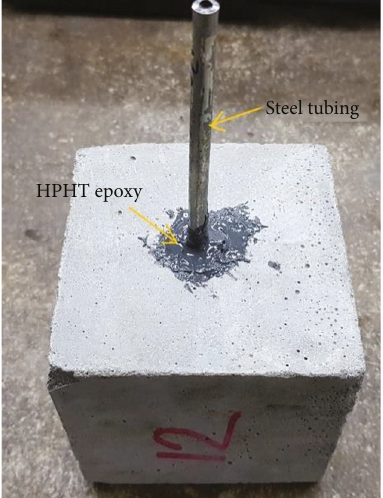
Figure 6: A view of cement block with steel tubing inserted and fi xed with HPHT